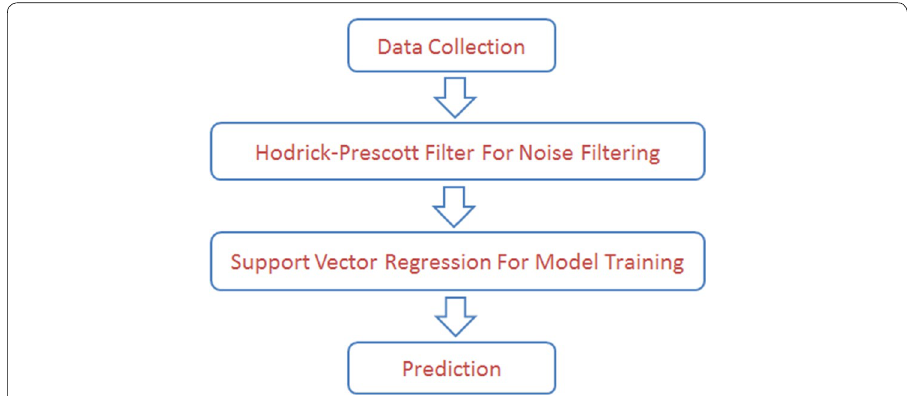
Fig. 1 Framework of stock market price